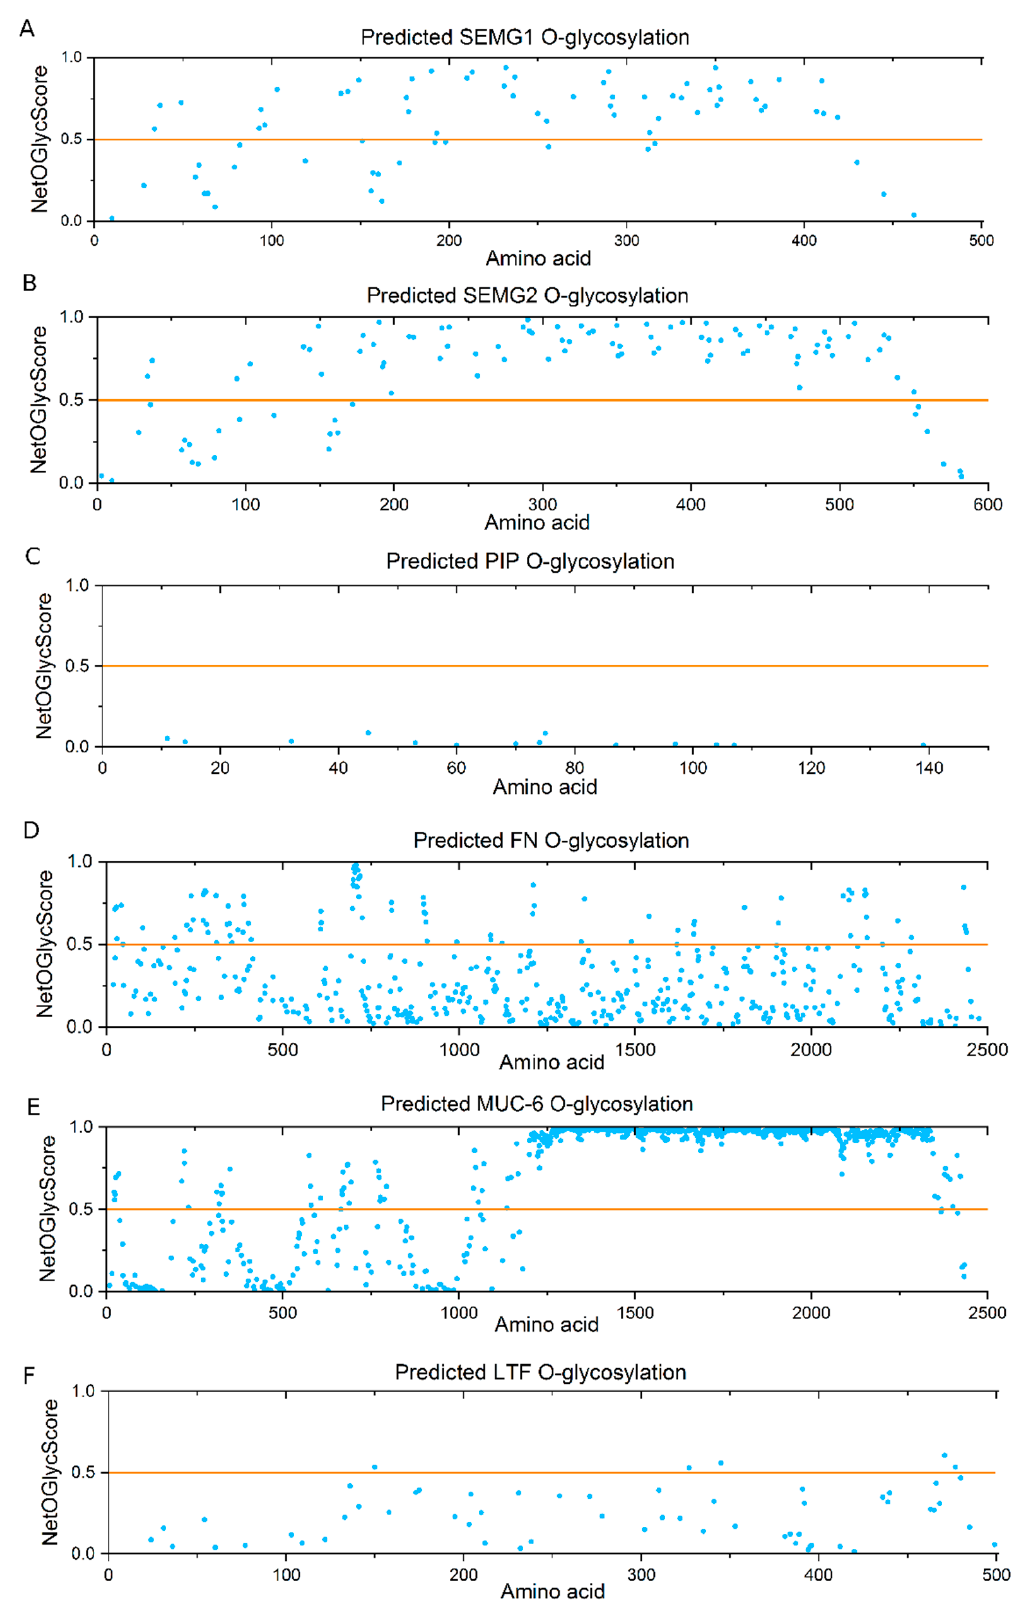
Figure 5. NetOGlyc analysis of the potential O-glycosylation sites on Ser/Thr residues in the selected seminal plasma glycoproteins. Residues with NetOGlyc 4.0 scores >0.5 indicate predicted O-linked glycans. Glycoproteins analyzed: ( A )—SEMG1; ( B )—SEMG2; ( C )—PIP; ( D )—FN; ( E )—MUC6; ( F